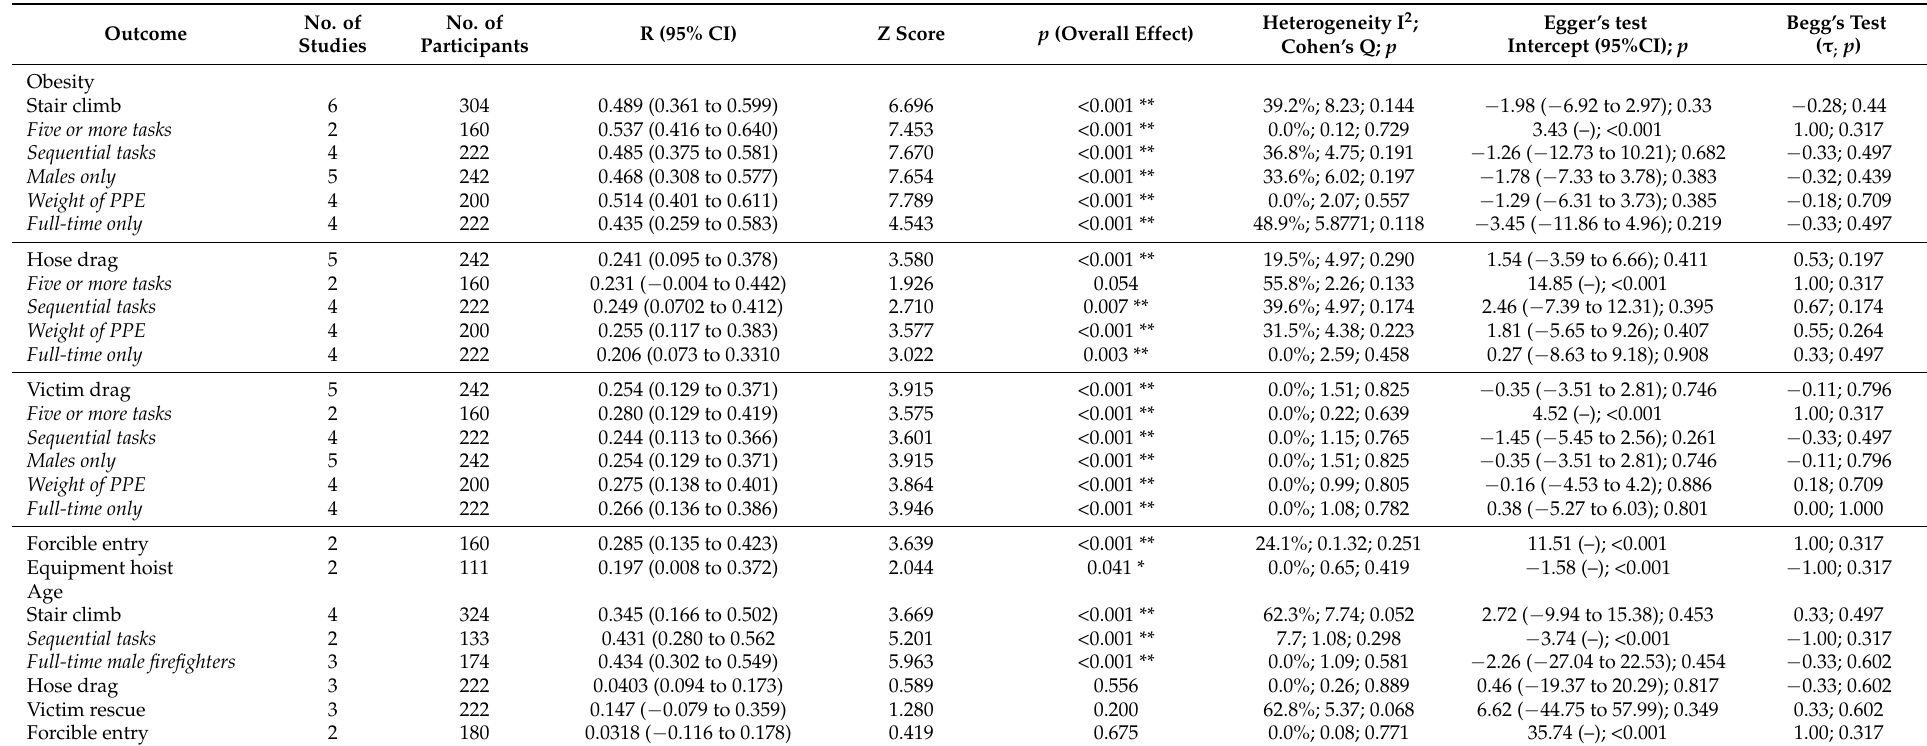
Table 6. The correlation between obesity and age, and individual task